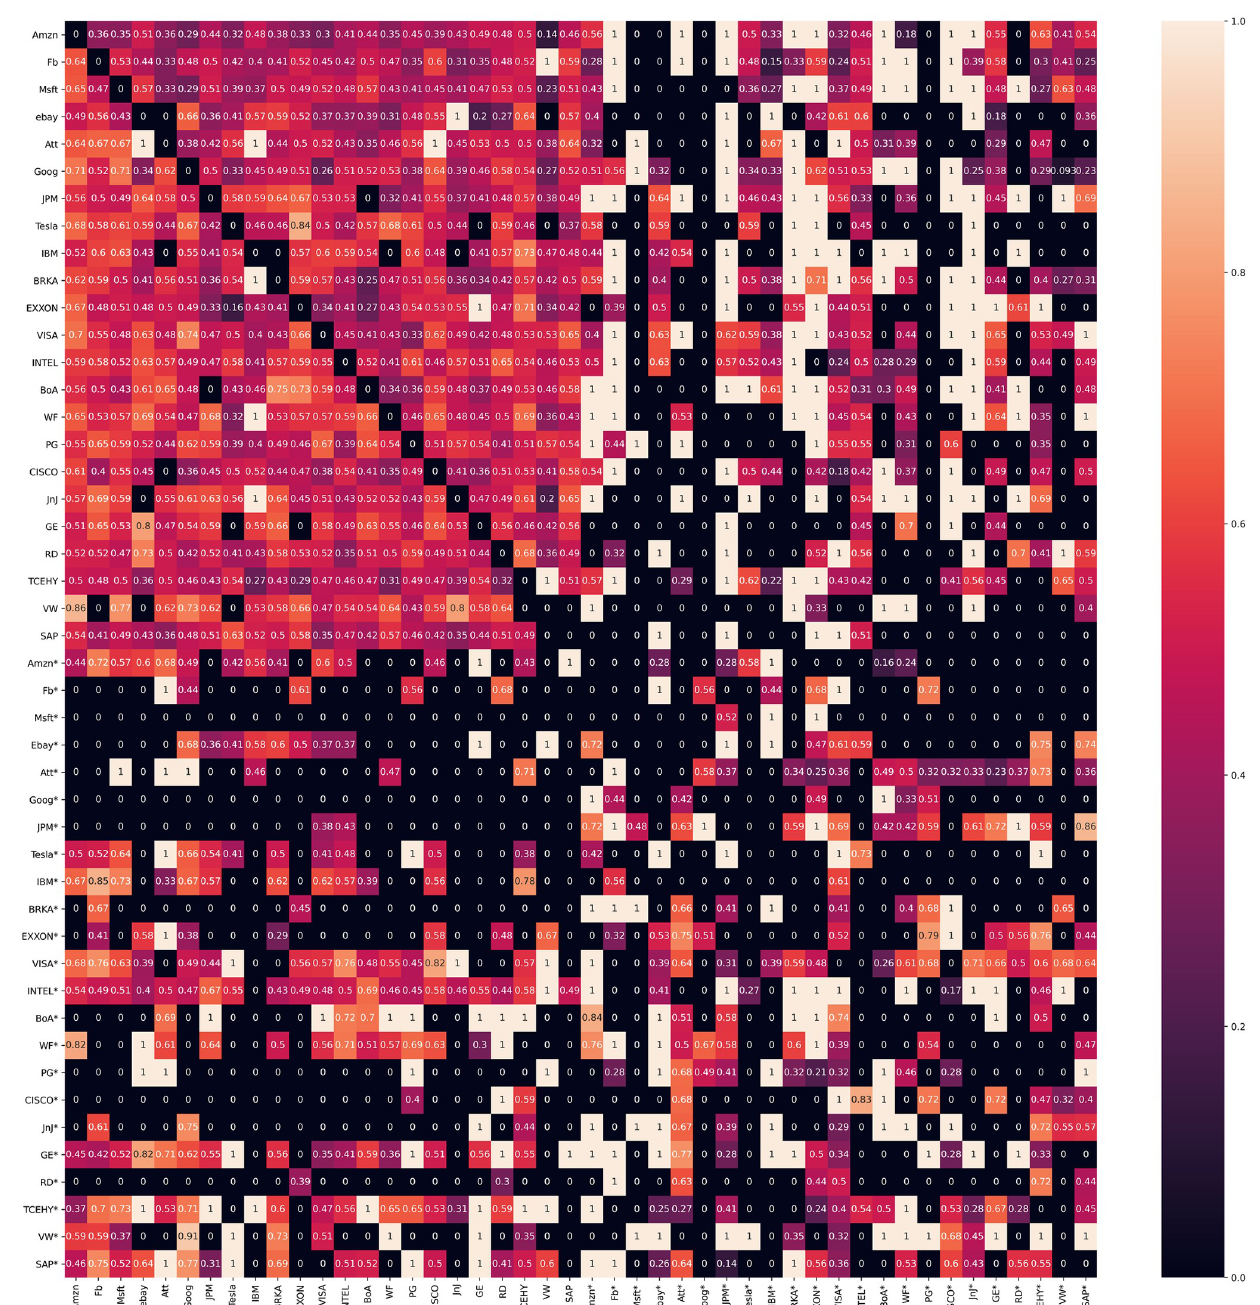
Fig 5. Shannon ETE matrix with a lag of 3 and p-value p � 0.10. Contrary to the correlation matrix there is information transfer between stock companies and the Sentiment